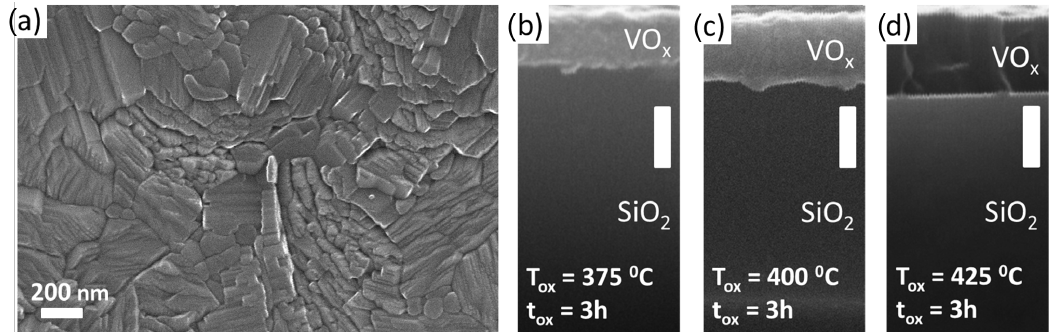
Figure 2. ( a ) Scanning electron microscope (SEM) micrograph of the top surface of a VO x film oxidized at 400 ◦ C for 3.0 h. ( b – d ) Series of SEM images of the cross section of VO x layers oxidized at different temperatures for 3.0 h. The thickness monotonically increases with the temperature. All white scale bars on the images indicate